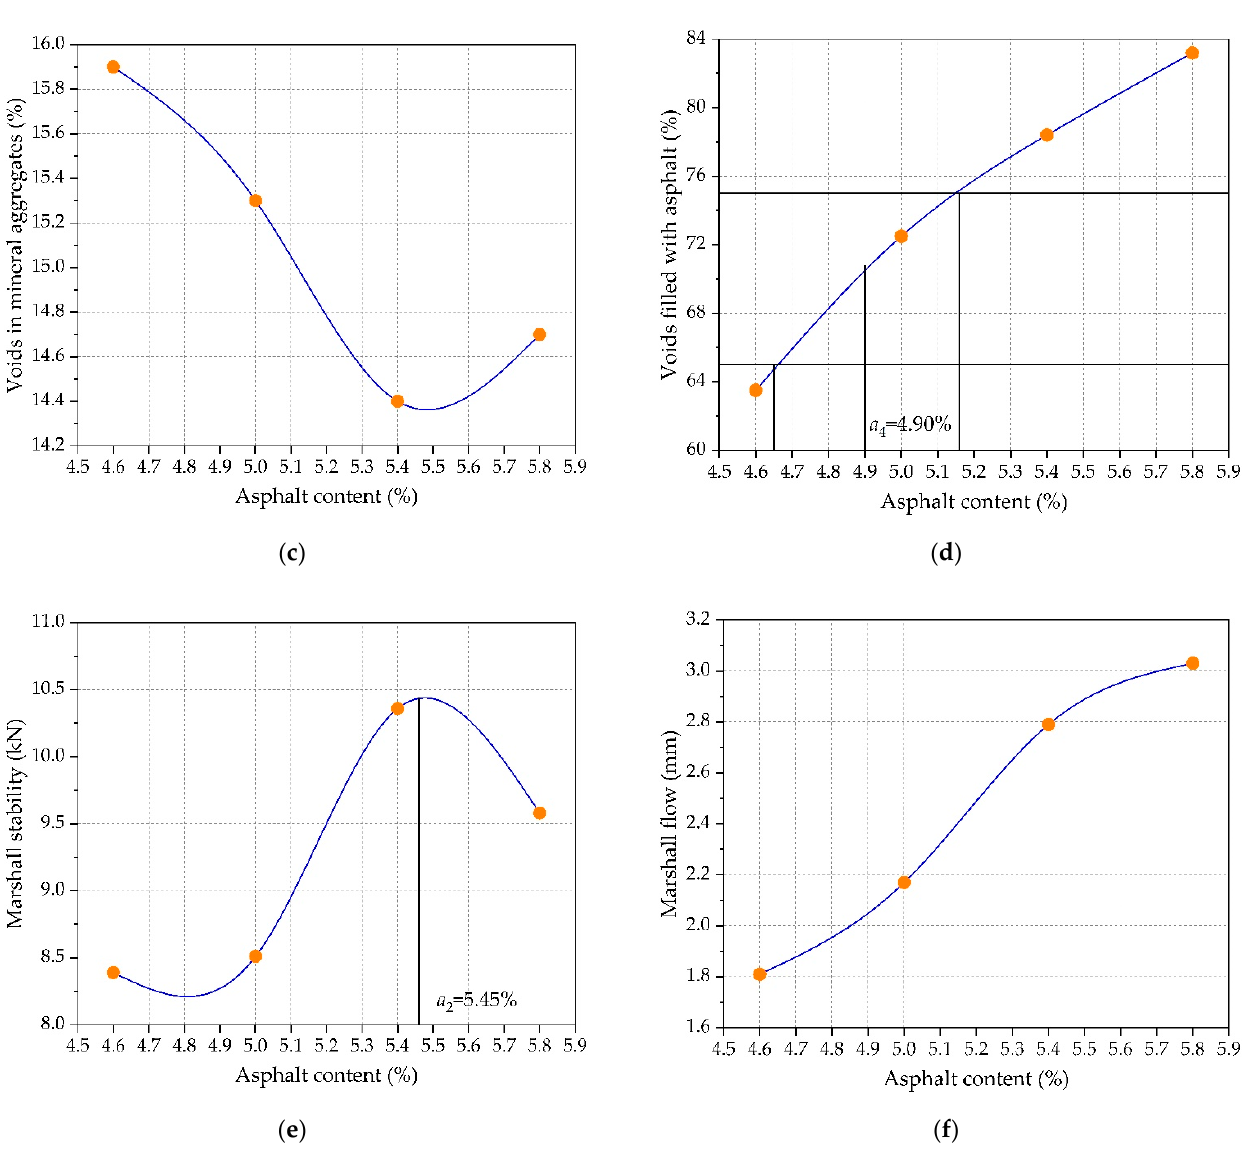
Figure 2. Marshall mix design results of AC-13: ( a ) bulk specific gravity; ( b ) air voids; ( c ) voids in mineral aggregates; ( d ) voids filled with asphalt; ( e ) Marshall stability; and ( f ) Marshall flow.